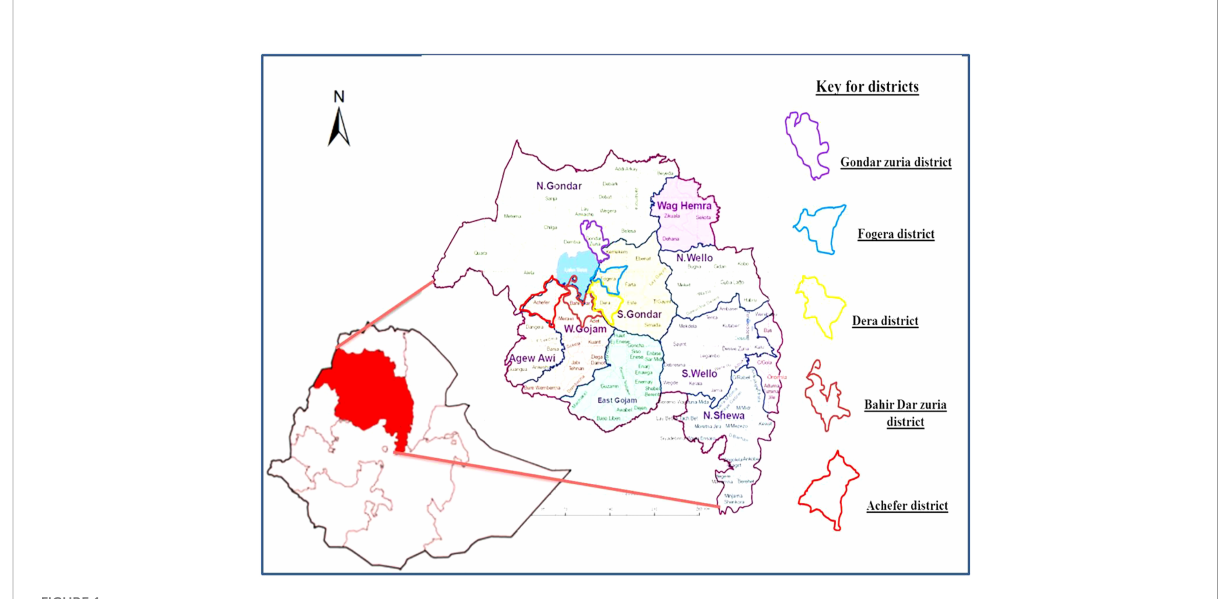
FIGURE 1 Map of the study districts (Source: Cafer and Rikoon,